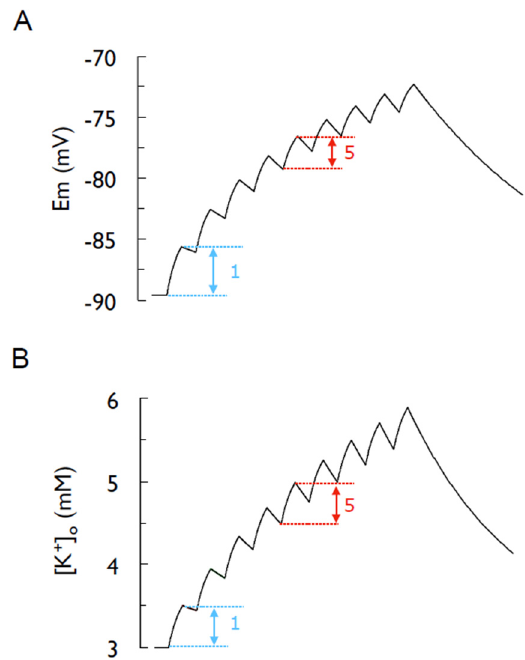
Figure 2. Stimulus-induced depolarisation of the glial cell membrane potential in Necturus optic nerve. ( A ) A model based on Em = 58 log ([K + ] o /99), illustrating the glial cell membrane potential depolarization in response to 9 sequential stimuli at 8 Hz, where each stimulus liberates the same amount of K + . ( B ) The elevation on [K + ] o that produces the depolarization in ( A ). Note how each stimulus raises [K + ] o by the same amount. Note how the arrows in ( B ) denoting the rise in [K + ] o associated with the 1st and 5th stimuli are identical in amplitude, but the membrane depolarisation associated with the 1st stimulus is larger than that for the